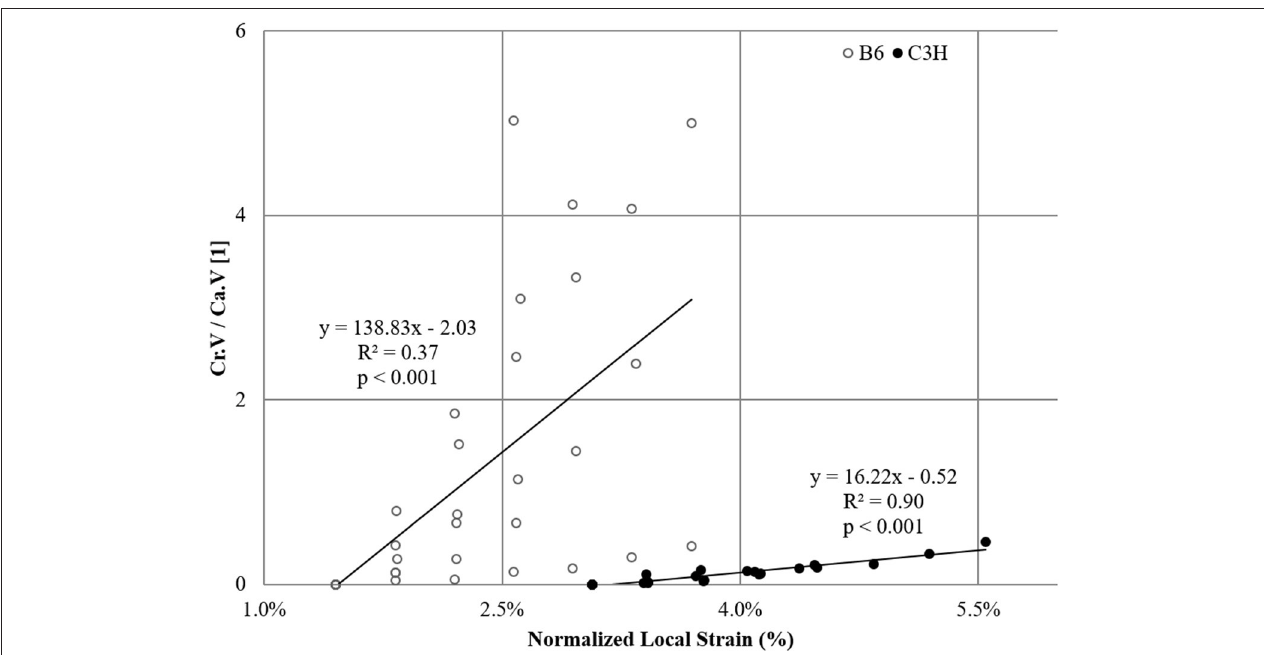
FIGURE 5 | Correlation between microcracks and canal network. Plotted is the volume ratio Cr.V/Ca.V (normalized crack volume) as a function of normalized local mechanical strains for B6 ( R 2 = 0.37, p < 0.001) and C3H ( R 2 = 0.90, p <